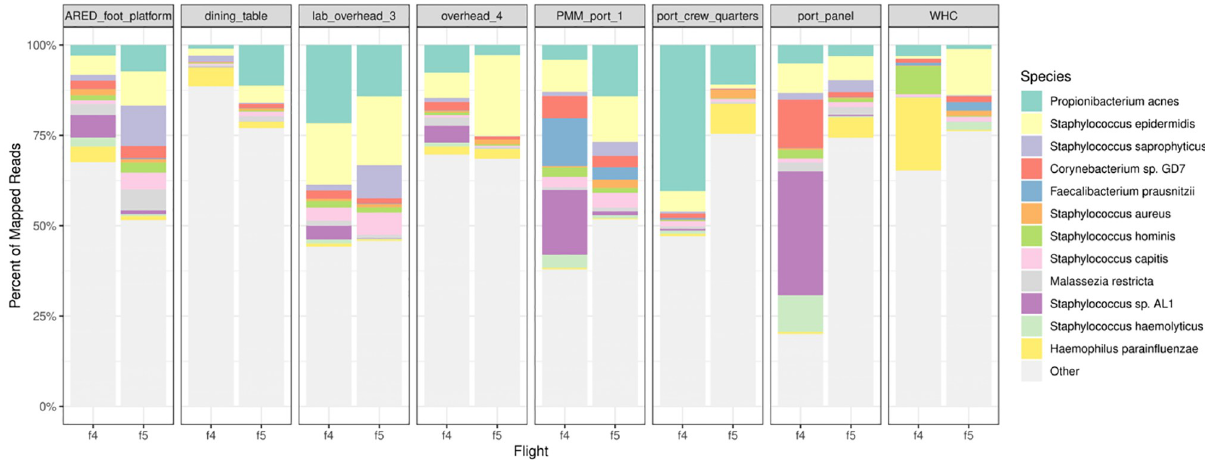
Fig 4. Relative abundances of top 12 species in environmental samples in Flights 4 and 5. The proportion of mapped microbial reads assigned to each genus is shown for each environmental sample. The top 12 genera are shown in colors and light grey (ranked by the average abundance in each panel summed across locations). Other less abundant genera are lumped together in lighter